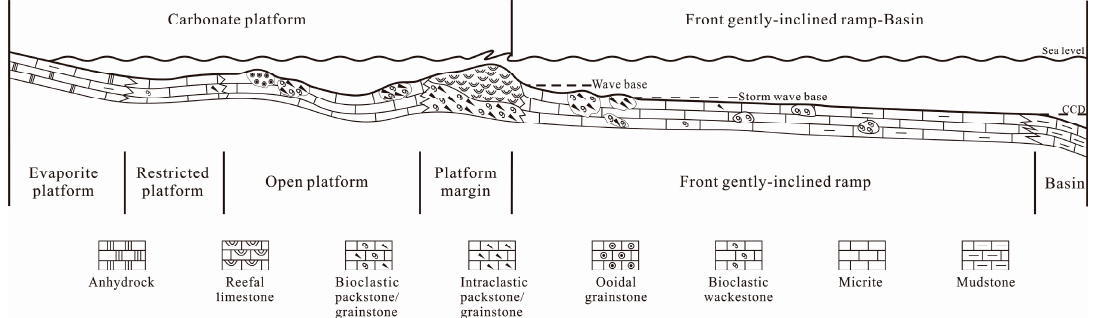
Figure 9. A sedimentary model of carbonate ramp (gently inclined slope) and rimmed platform of Callovian-Oxfordian Stage in Amu Darya Basin (Reference [8,16]).